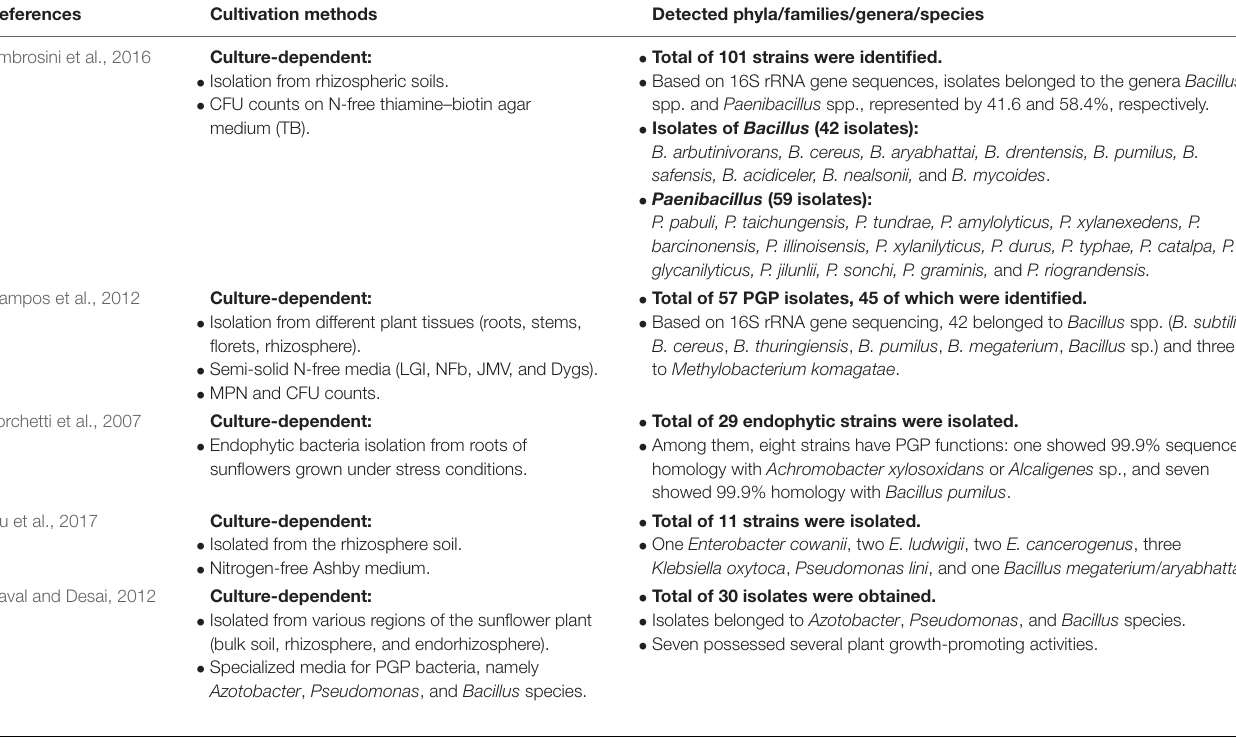
TABLE 3 | Literature related to the diversity and community composition of sunflower microbiota as recovered by various culture-dependent techniques and culture media.